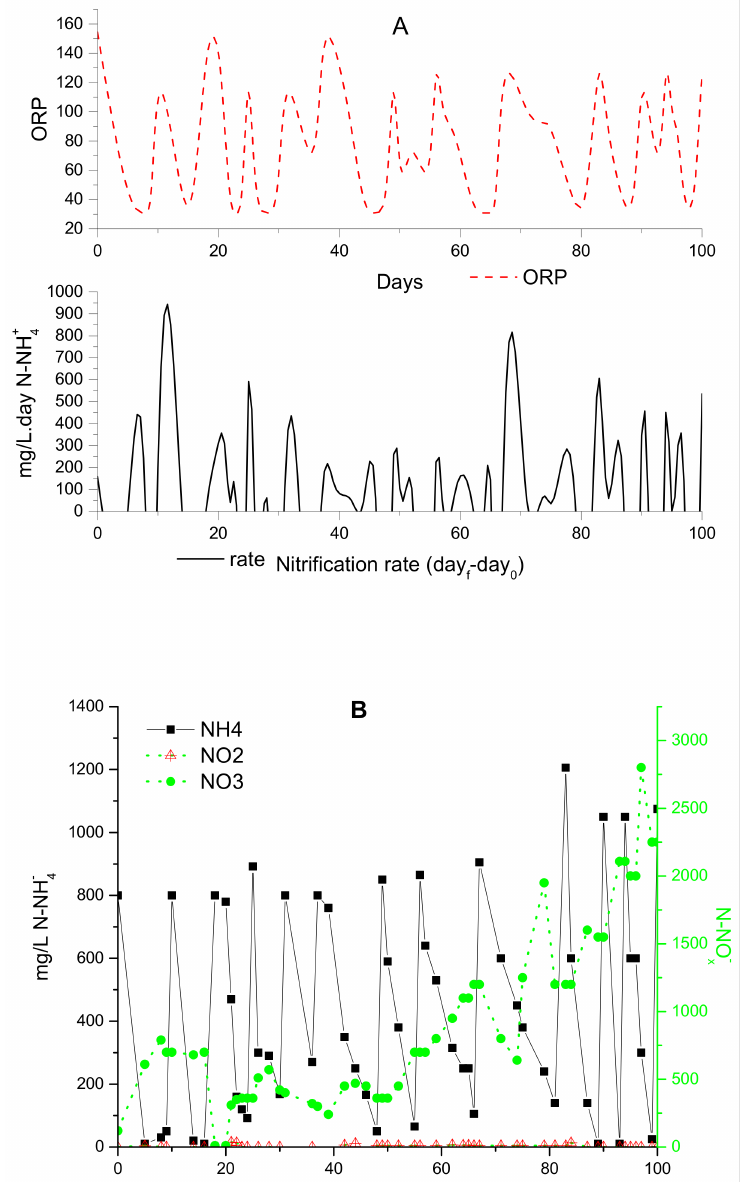
Figure 11. Nitrification in semi-continuous process at 100 days with attached biomass: ( A ) ORP measured (above figure) and nitrification rate (below figure) ( B ) Ammonium conversion in the nitrification